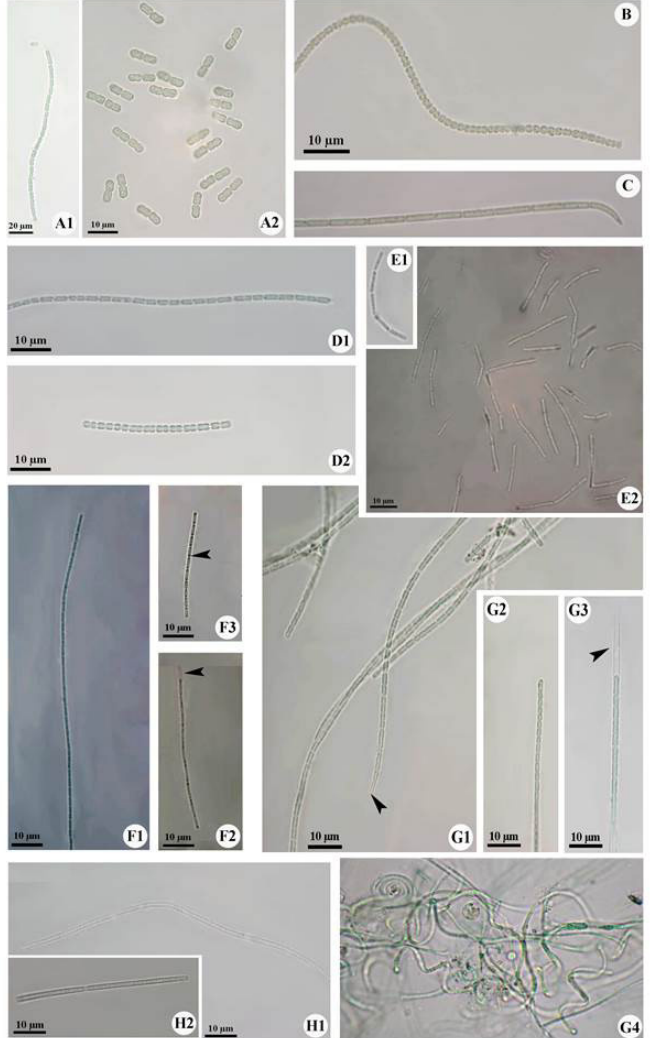
Figure 2. Benthic cyanobacterial morphospecies in meltwater ponds along environmental gradients in the McMurdo Sound region. (